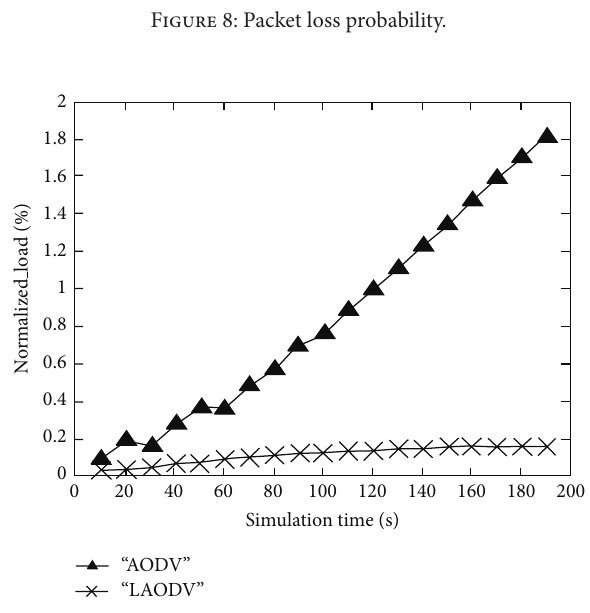
Figure 9: Routing